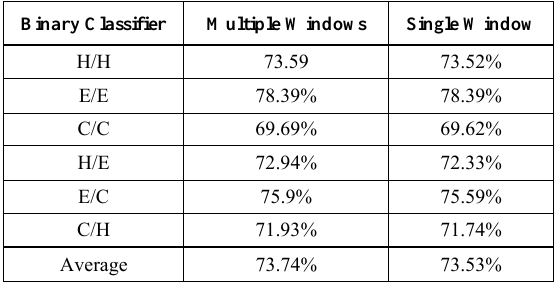
Table 2 Comparing Single Window and Multiple Windows